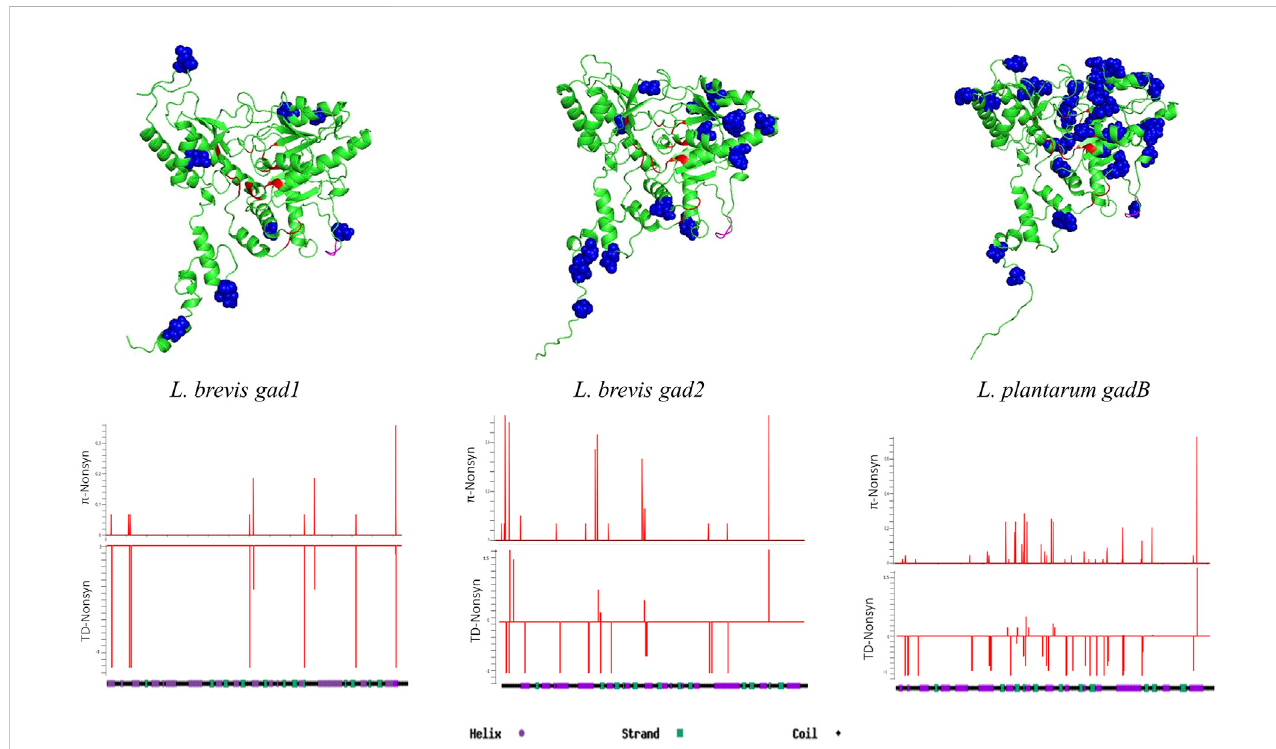
FIGURE 2 3D structure predictions for Gad1, Gad2, and GadB proteins. Blue colored residues represent replacement sites, red colored residues represent ligand and cofactor (PLP) binding sites, and pink colored residues represent the fl exible loop region. Sliding-window analyses show non-synonymous nucleotide diversity ( π ) and Tajima ’ s D test results throughout the